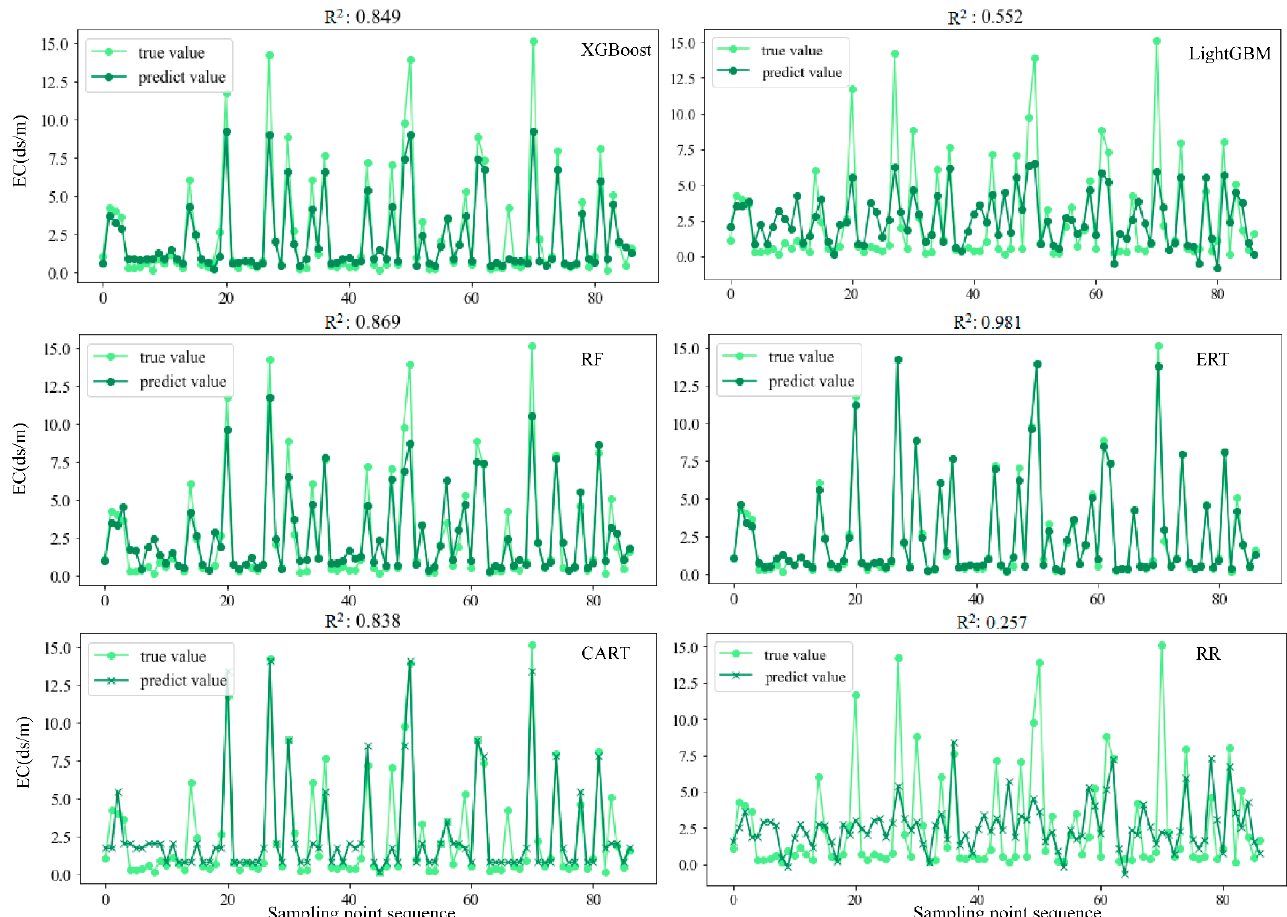
Figure 8. The training set fitting effect diagrams and scores of six machine learning methods: extreme gradient boosting (XGBoost), light gradient boosting machine (LightGBM), random forest (RF), ex- tremely randomized trees (ERT), classification and regression tree (CART), and ridge regression (RR).